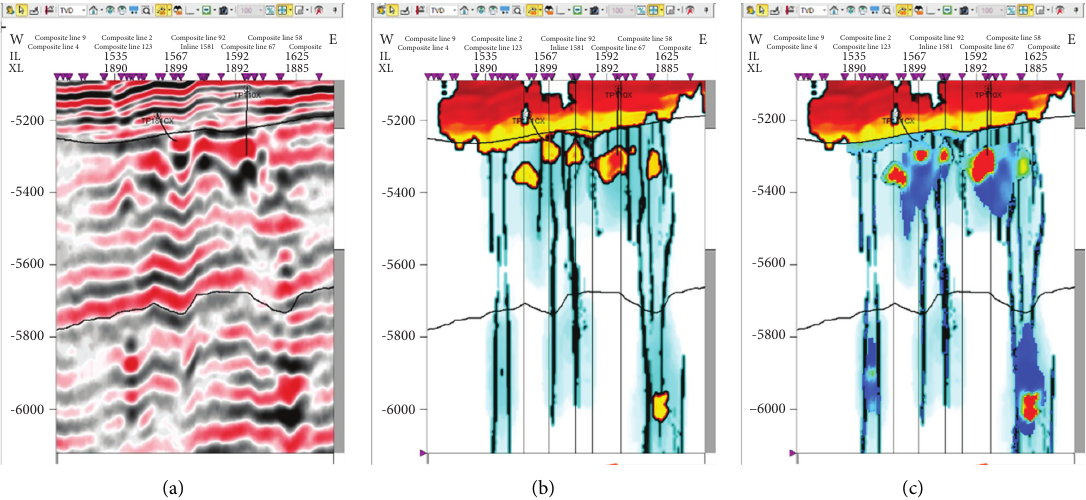
Figure 1: A fault-solution reservoir in Tahe Oilfield: (a) original seismic map, (b) attribute fusion map, and (c) porosity fusion